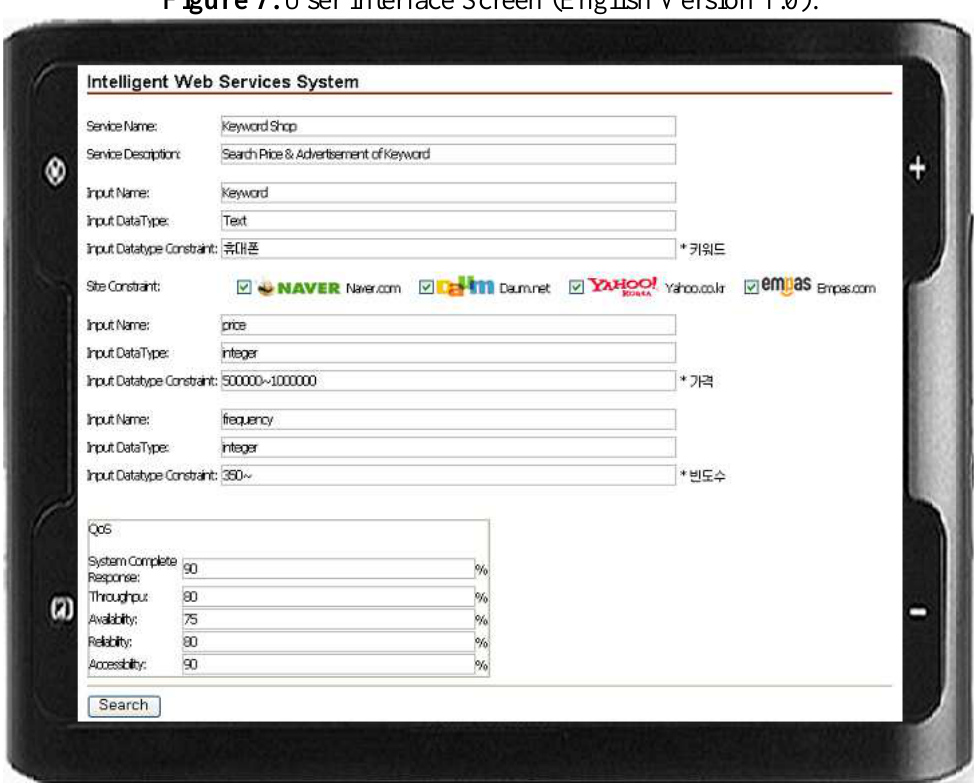
Figure 7. User Interface Screen (English Version